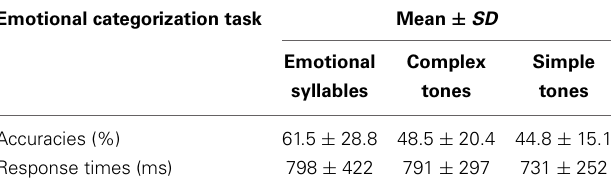
Table 1 | Behavioral performance.